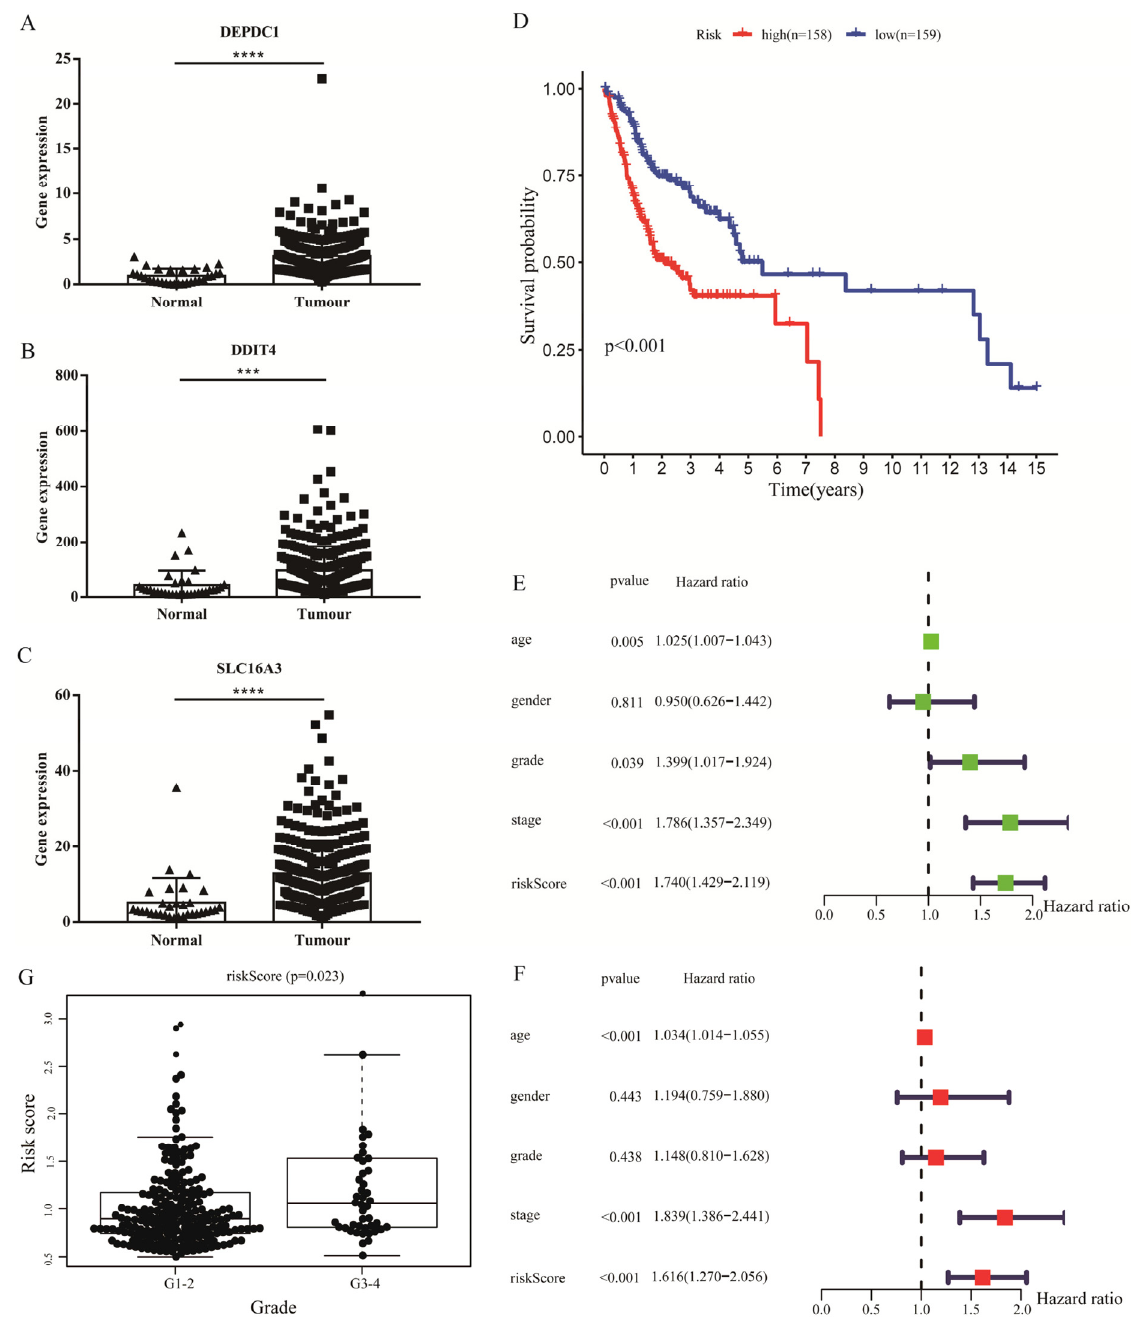
Figure 2. Identification of prognostic Cox model. The expression level of 3 genes, DEPDC1 (( A ), p < 0.0001), DDIT4 (( B ), p = 0.0008) and SLC16A3 (( C ), p < 0.0001), included in the risk Cox formula in TCGA. Triangle and square stand for gene expression level in normal and tumor samples, respec- tively. ( D ); Survival analysis between high- and low-risk levels according to risk scores calculated from the DEPDC1, DDIT4 and SLC16A3 expression profiles of each patient. ( E , F ), Univariate and multivariate Cox regression analyses on the basis of risk score. ( G ), High risk score might mean poor grade level in OSCC. Significant differences were considered at p < 0.001 ***; and p < 0.0001 ****.